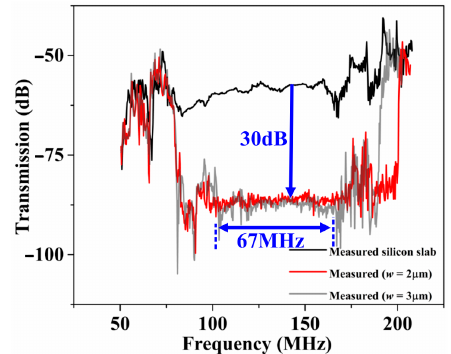
Figure 4. Measured transmission S 21 of the three delay lines showing the existence of the bandgap associated with the solid disk PnC observed through the 30 dB drop in transmission within a wide stop band.